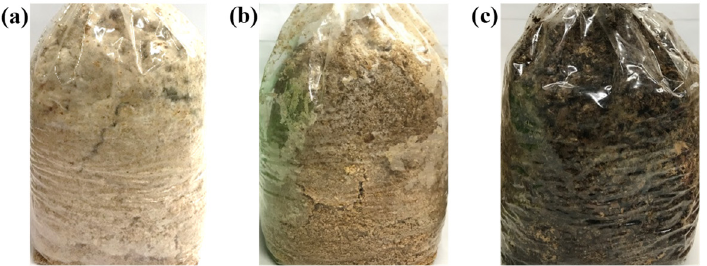
Figure 6. Effect of pasteurization method on the appearance of the solid-state fermented W. cocos products: ( a ) control, ( b ) RF heating for 30 s, and ( c ) 121 °C autoclaving for 60 min.